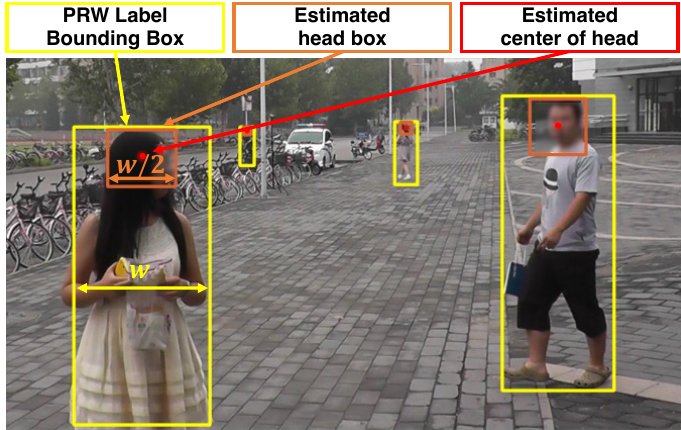
Figure 5. An illustration of head approximation for the relabeling process.